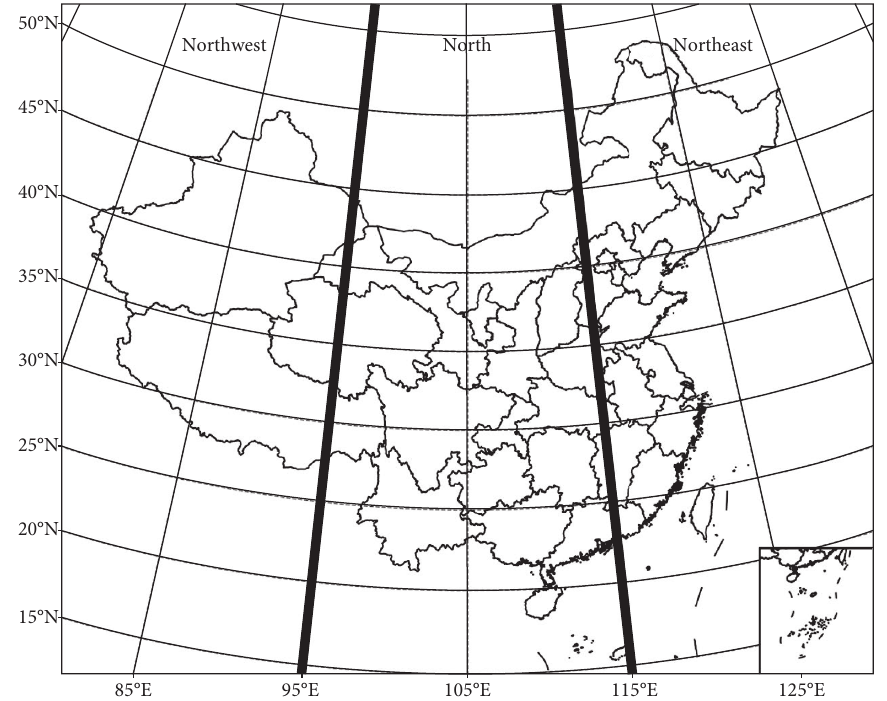
Figure 2: Division of source regions of the CAI